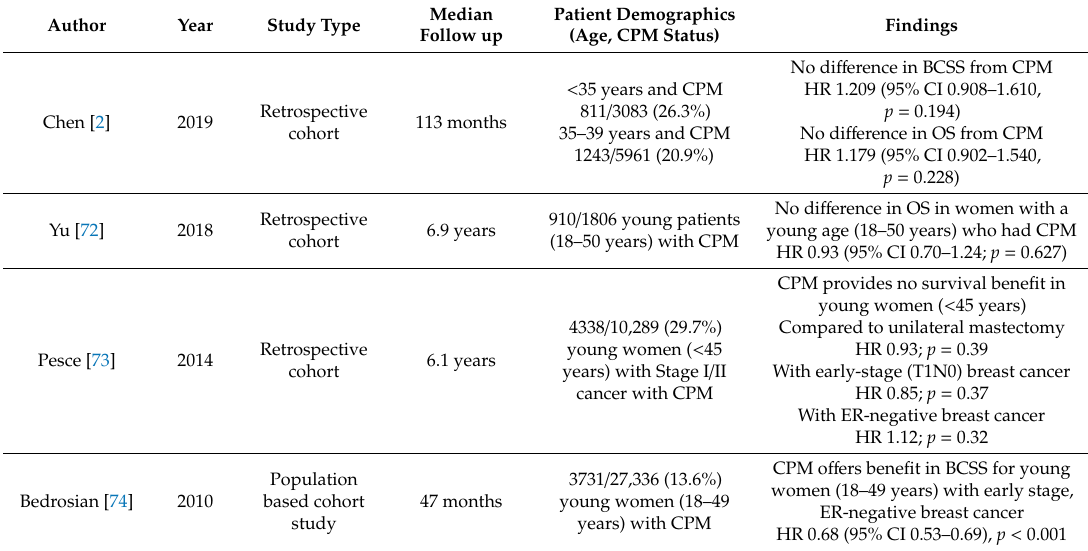
Table 5. Studies looking at the impact of CPM on CBC and survival in young women with breast